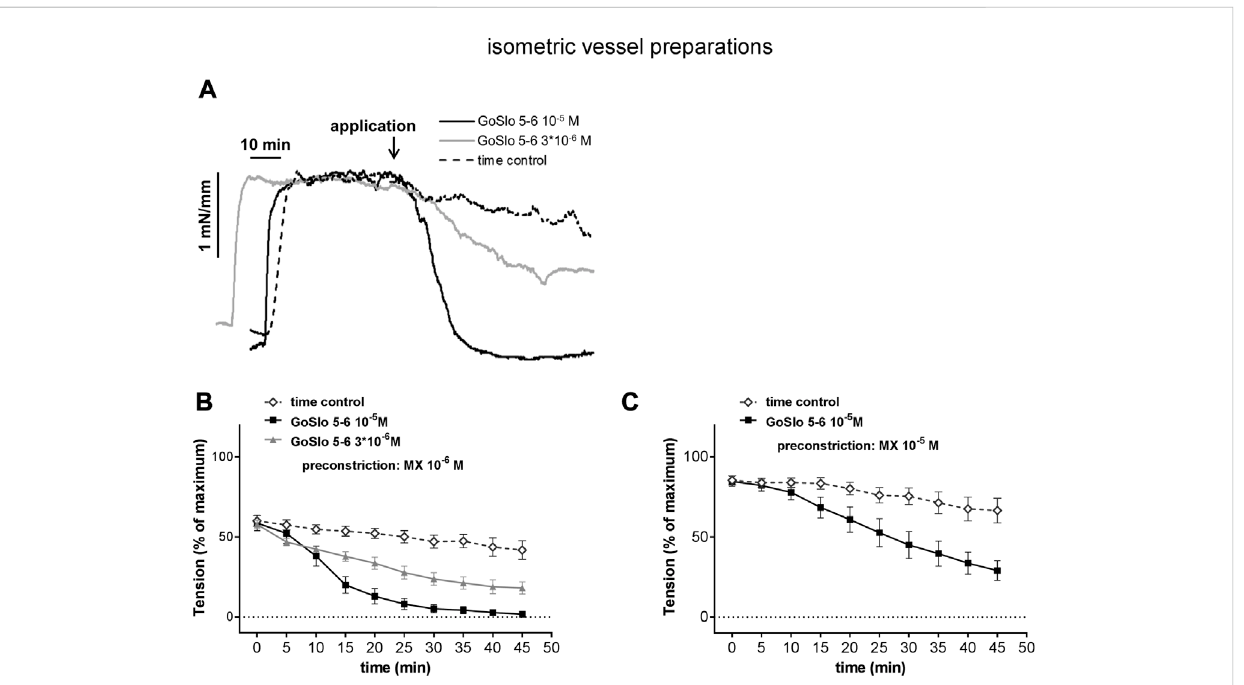
FIGURE 4 GoSlo-SR-5-6 causes concentration dependent relaxations of isometric preparations of rat Gracilis muscle arteries. (A) Example of the effect of GoSlo 5-6 on tension of an isometric vessel preparation at 10 – 6 M MX-induced tone. Application denotes the time point where GoSlo or vehicle was added. (B) Effect of GoSlo 5-6 on 10 – 6 M MX-induced contraction. Vessel tension in the absence (time control) and presence of GoSlo 5-6 at 3 × 10 − 6 M and at 10 – 5 M (repeated measures ANOVA: con vs. GoSlo 10 – 5 M - n = 11; p < 0.05; con vs. GoSlo 3 × 10 − 6 M — n = 8; p < 0.05; GoSlo 10 – 5 M vs. 3